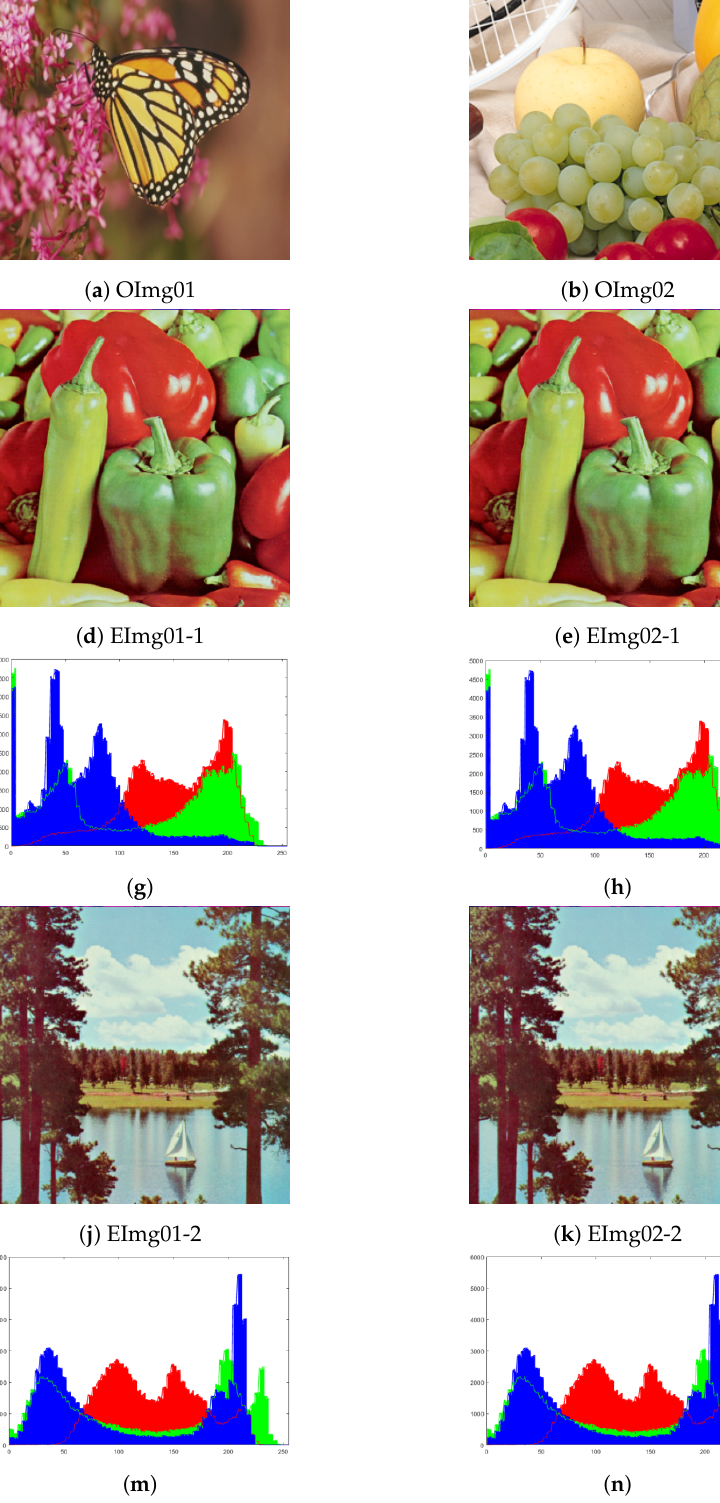
Figure 5. Outcomes of simulation tests for pairings of original and reference colour images in the dataset presented earlier in Figures 3 and 4. The original images are presented in the first row ( a – c ), while their encrypted versions with the Peppers (RImg01) image as reference image are presented in the second row ( d – f ). Third row ( g – i ), presents histograms of the encrypted versions of these images. Similarly, the fourth row ( j – l ) presents encrypted versions of the original images with Lake (RIm02) image as reference image, and their respective histograms are presented in the last row ( m – o